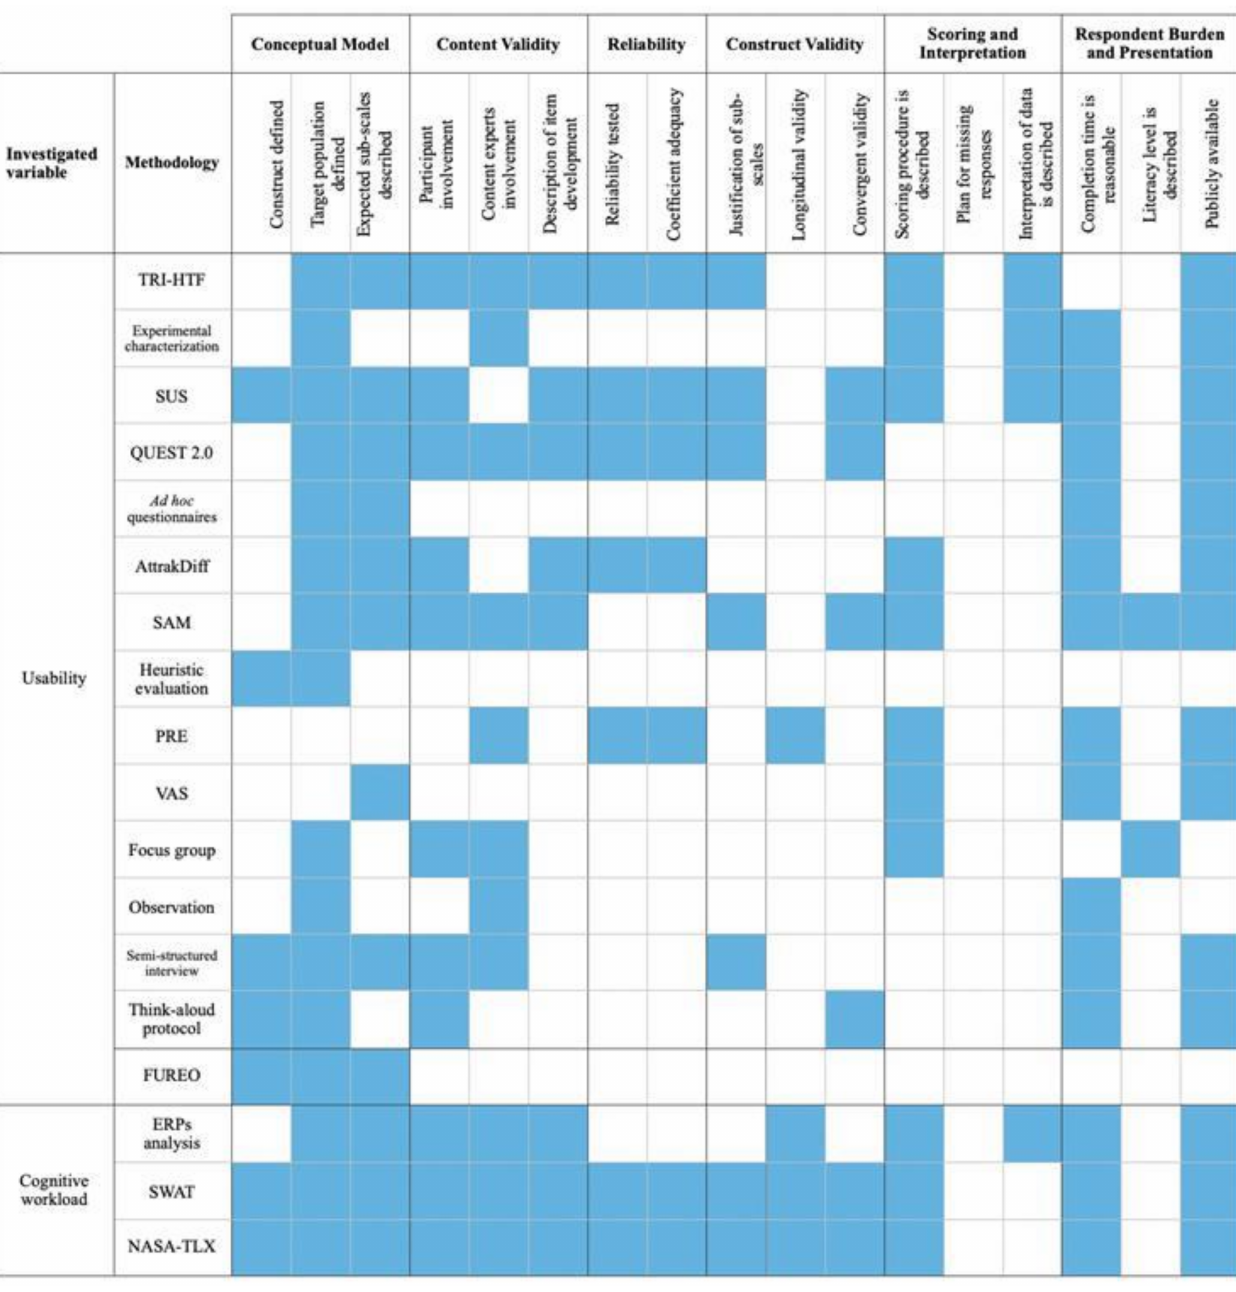
Figure 2. Critical appraisal of the retrieved assessment methods of usability and cognitive workload in the use of rehabilita- tive exoskeletons based on the adaptation of the checklist from Francis and colleagues